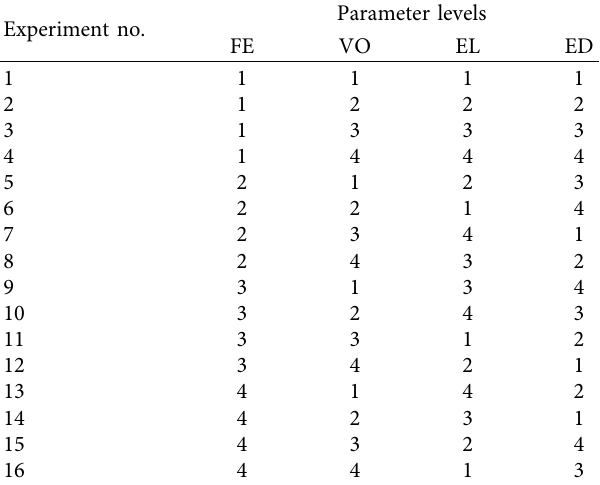
Table 4: Interaction of parameter levels.